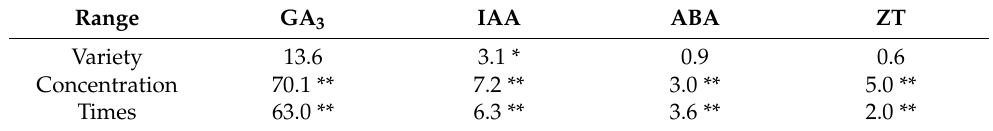
Table 4. Range analysis of the L9 (3 4 ) orthogonal experimental design for endogenous hormones. Range GA 3 IAA ABA ZT Variety 13.6 3.1 * 0.9 0.6 Concentration 70.1 ** 7.2 ** Times 63.0